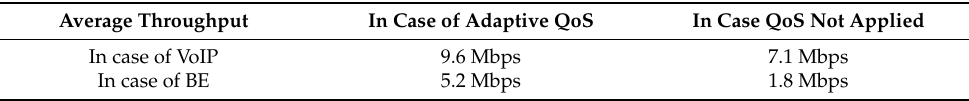
Table 12. Scenario 2 Throughtput